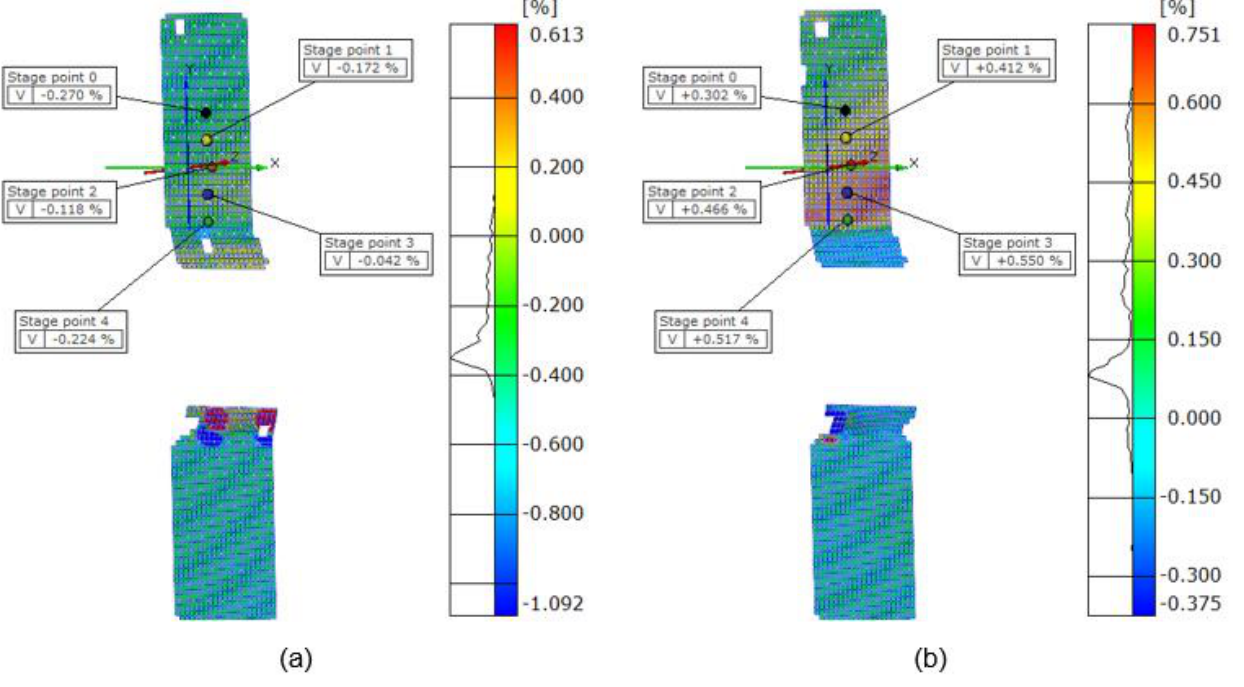
Figure 8. Longitudinal strain: ( a ) minimum value of displacement and ( b ) maximum value of displacement; (da = 0.35 mm).